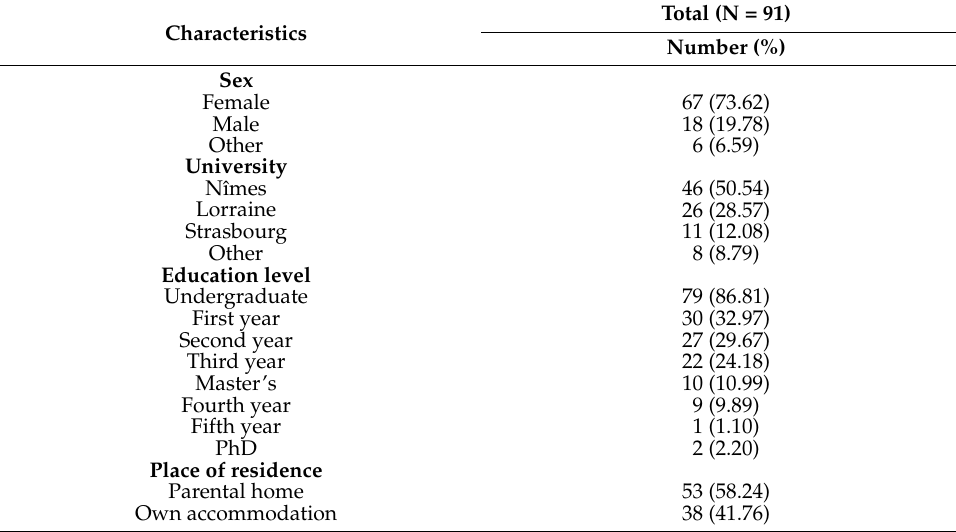
Table 1. Characteristics of the survey